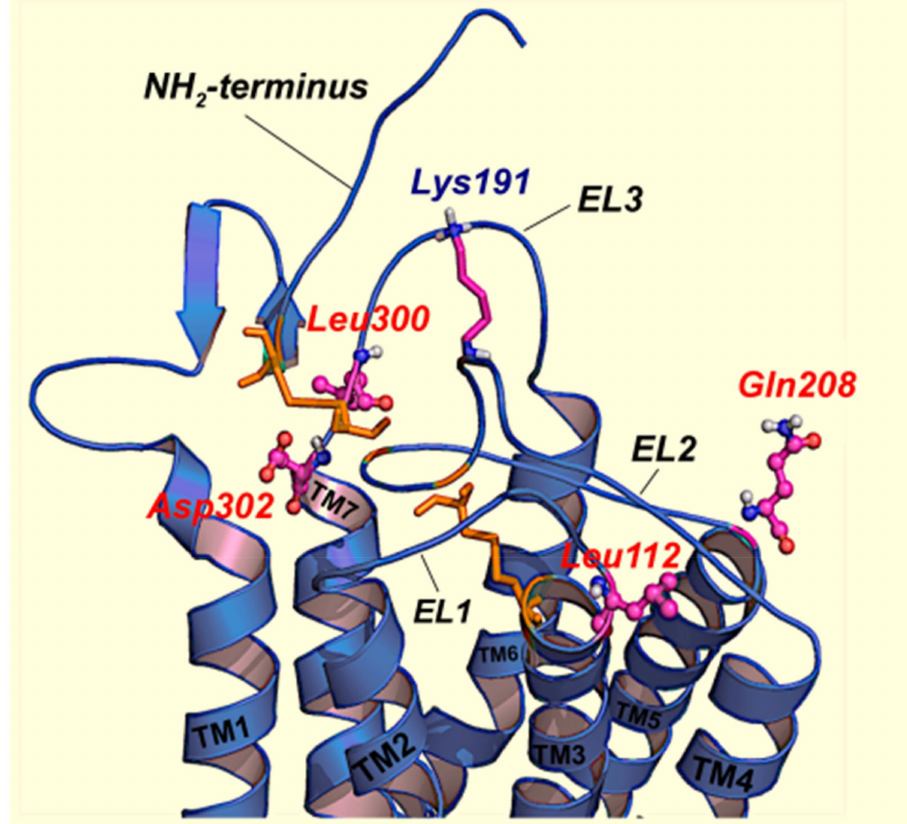
Figure 2. Predicted structure of the upper-third portion of the hGnRHR based on homology modeling with the structure of bovine rhodopsin [76]. The antiparallel α -helices of transmembrane domains (TM) 1 to 7 are represented by the coiled structures. These TM domains are connected by the extracellular loops (EL) of the receptor (blue curved cords). Disulfide bonds between C14 and C200 (connecting the the NH 2 -terminus and the EL2), as well as between C114 and C196 (at the COOH- terminal end of the EL1 and at the EL2) are shown as orange sticks. The location of the amino acid residues that represent a motif of four non-contiguous residues at positions L112 (at the EL1), Q208 (at the EL2), L300 (at the EL3), and D302 (at the EL3) that presumably control the destabilizing role of K191 (shown as purple, blue, and grey color sticks, at the EL2) on the association of the NH 2 -terminus and the EL2 and subsequent formation of the C14–C200 disulfide bridge, are shown in colored circles and sticks (see the text and Refs. [64,69] for data and